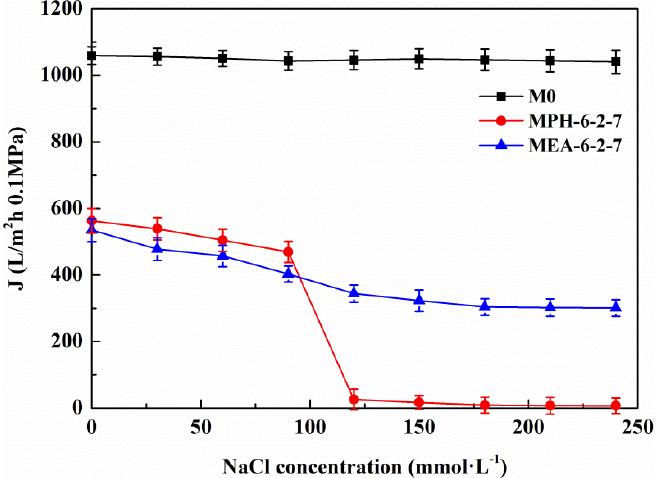
Figure 7. Permeate flux of aqueous solution with different NaCl concentrations through various membranes.